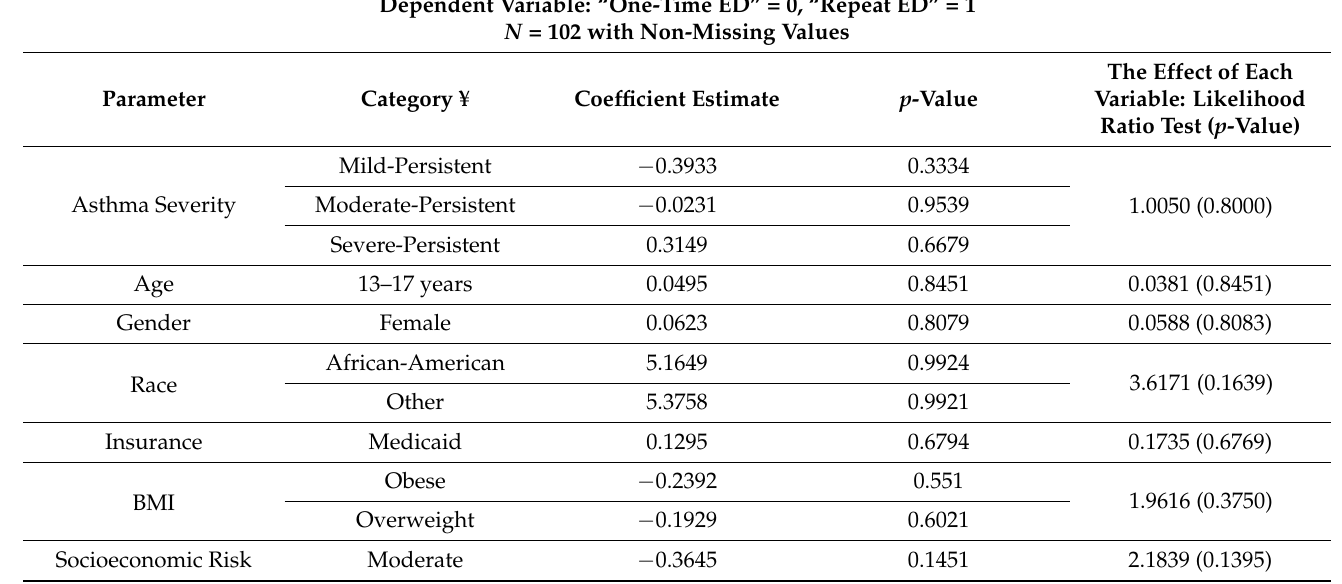
Table 6. Logistic regression analysis (Round 2 analysis: 8–17